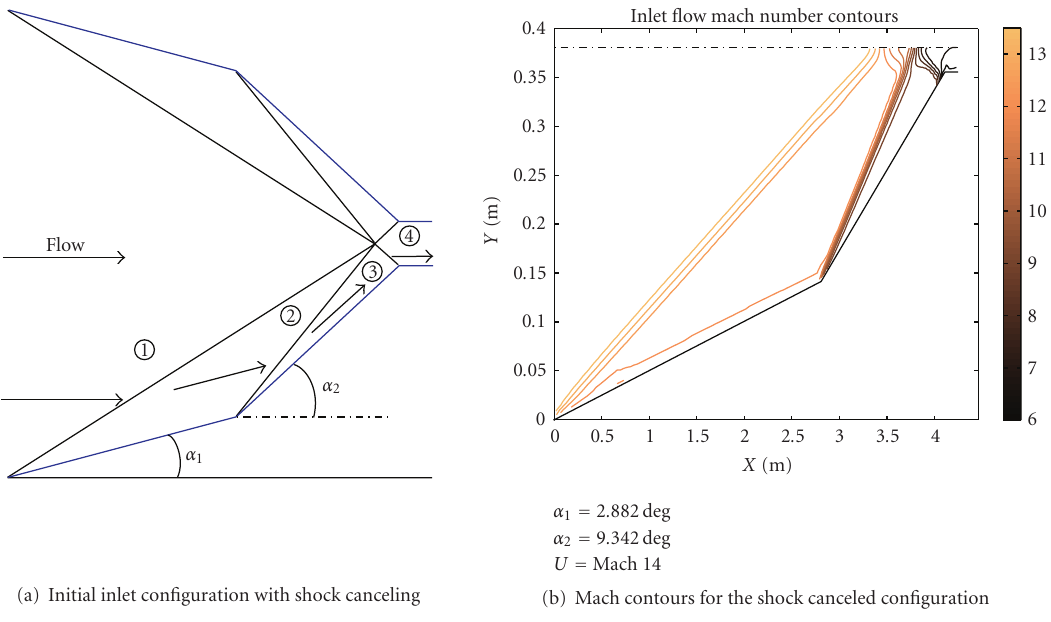
Figure 4: Full inlet demonstrating initial conditions—Shock-canceled case.